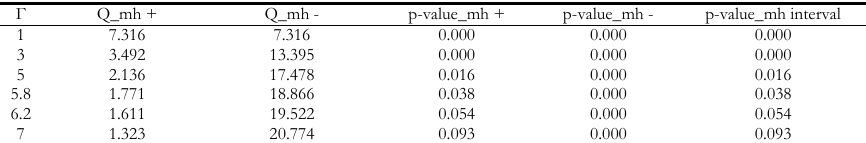
Sensitivity analysis: p-value bounds of the Mantel-Haenszel